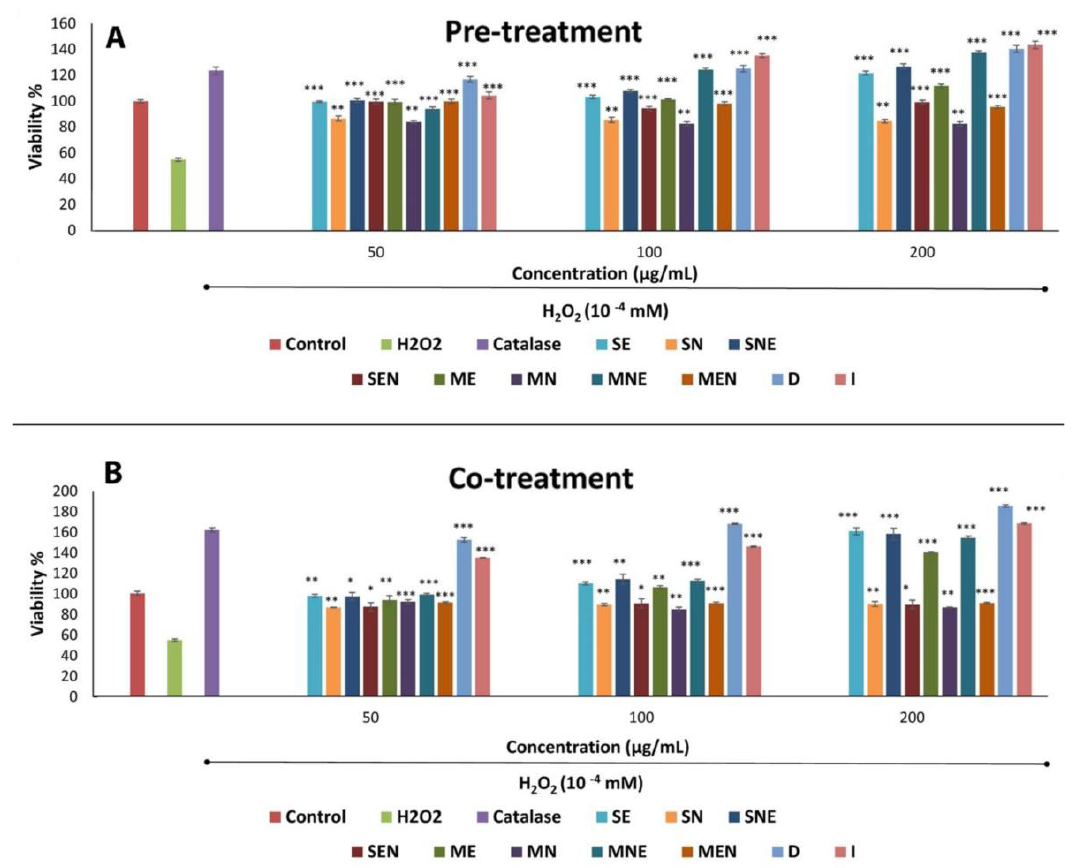
Figure 1. Effect of TS extracts on H 2 O 2 -induced damage in fibroblasts after pre-treatment (A) and co-treatment (B) protocols. Data were presented as mean ± SEM (n = 3) and compared with H 2 O 2 treated group, * p < 0.05, ** p < 0.01, *** p < 0.001. SE—Soxhlet ethanol, SN—Soxhlet n -hexane, SNE—Soxhlet